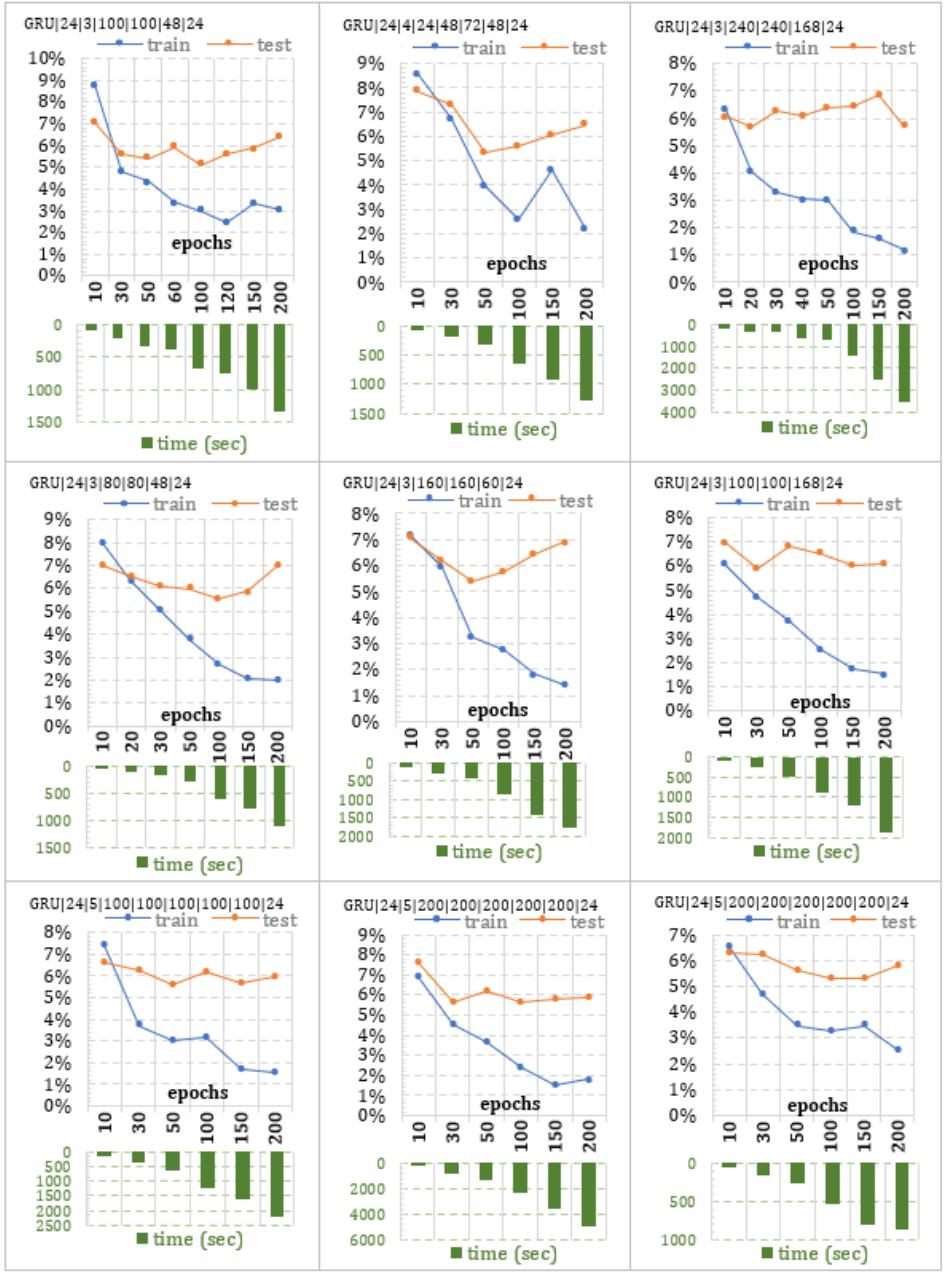
Figure 11. The various structures for the analysed GRU deep